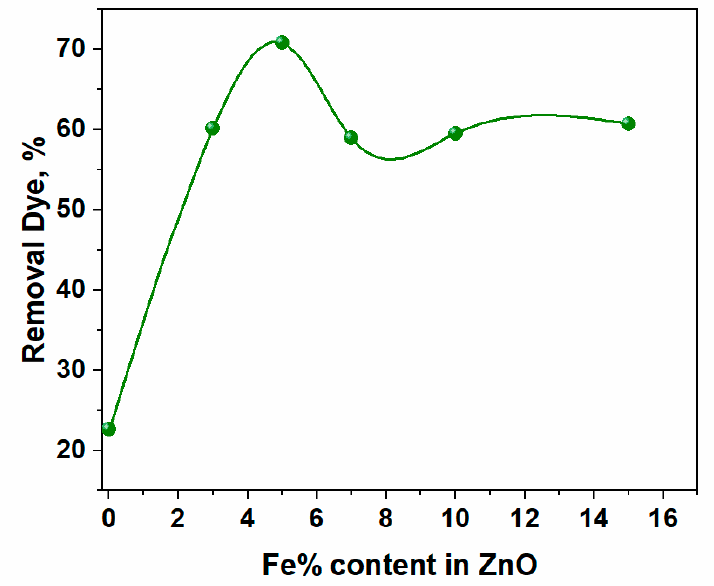
Figure 9. The efficiency of different concentrations of Fe in ZnO.